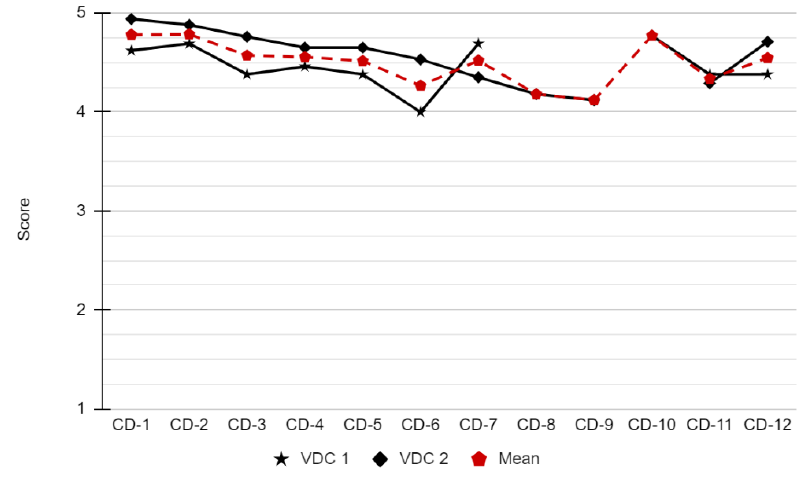
Fig. 4. Survey results on students’ perceptions about the design of VDC I and VDC II courses